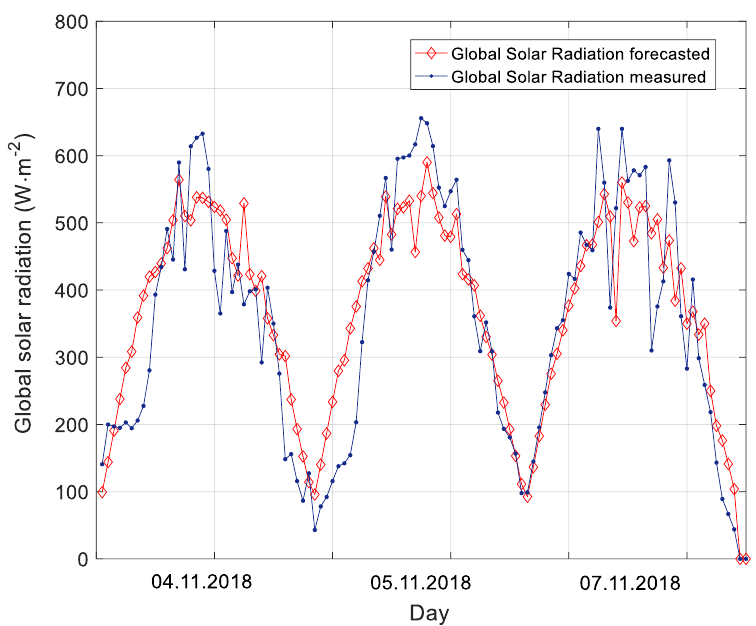
Figure 5. The forecasted results of GHI under partly cloudy skies with a 60 min horizon (04.11.2018, 05.11.2018, and 07.11.2018), total of 108 samples of the test set. Table 2. Statistical indexes for partly cloudy skies with horizons from 15–180 min (in W / m 2 for the root mean square error (RMSE), the mean absolute error (MAE), the mean bias error (MBE)). Metric